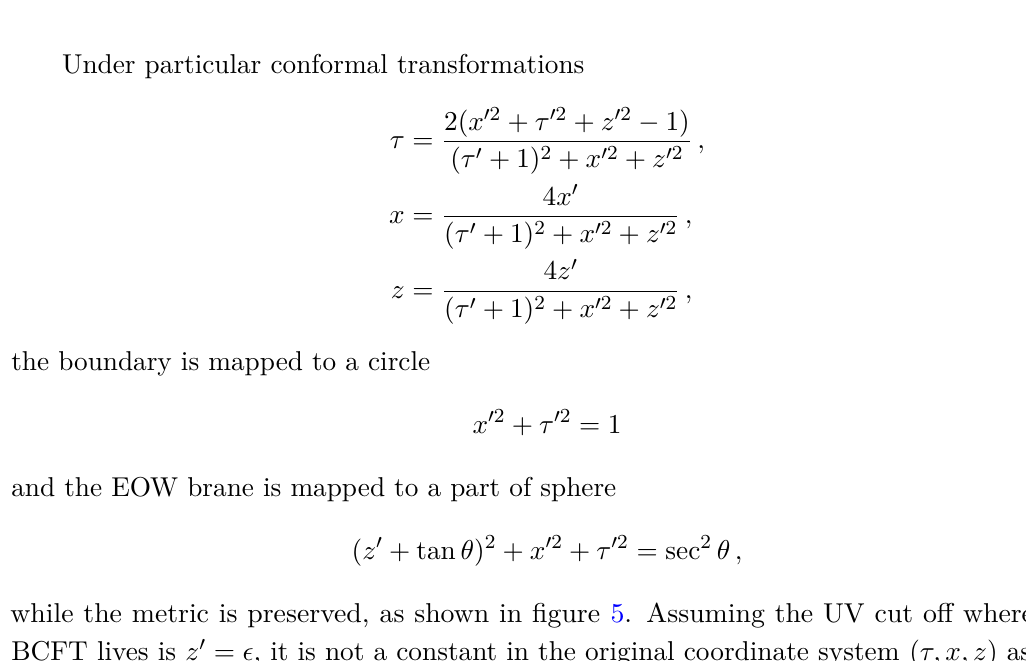
Figure 4 . Holographic dual of Euclidean BCFT defined on half spacetime ( τ > 0)